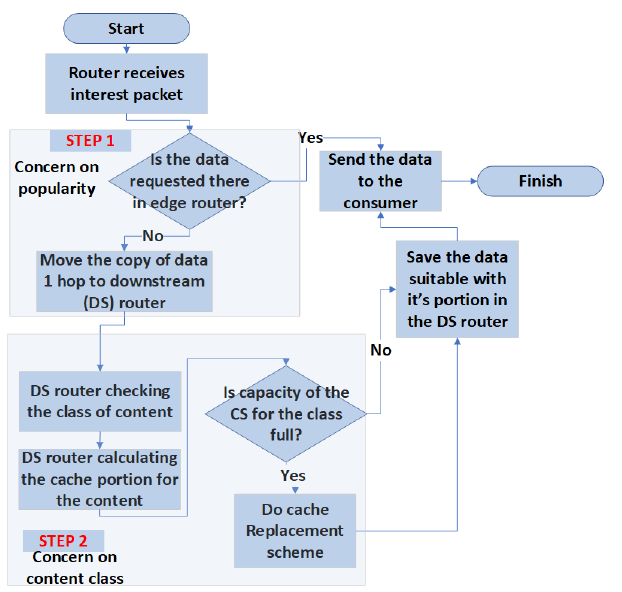
Figure 1. Flowchart of Cache Based on Popularity and Class (CAPIC) caching mechanism.